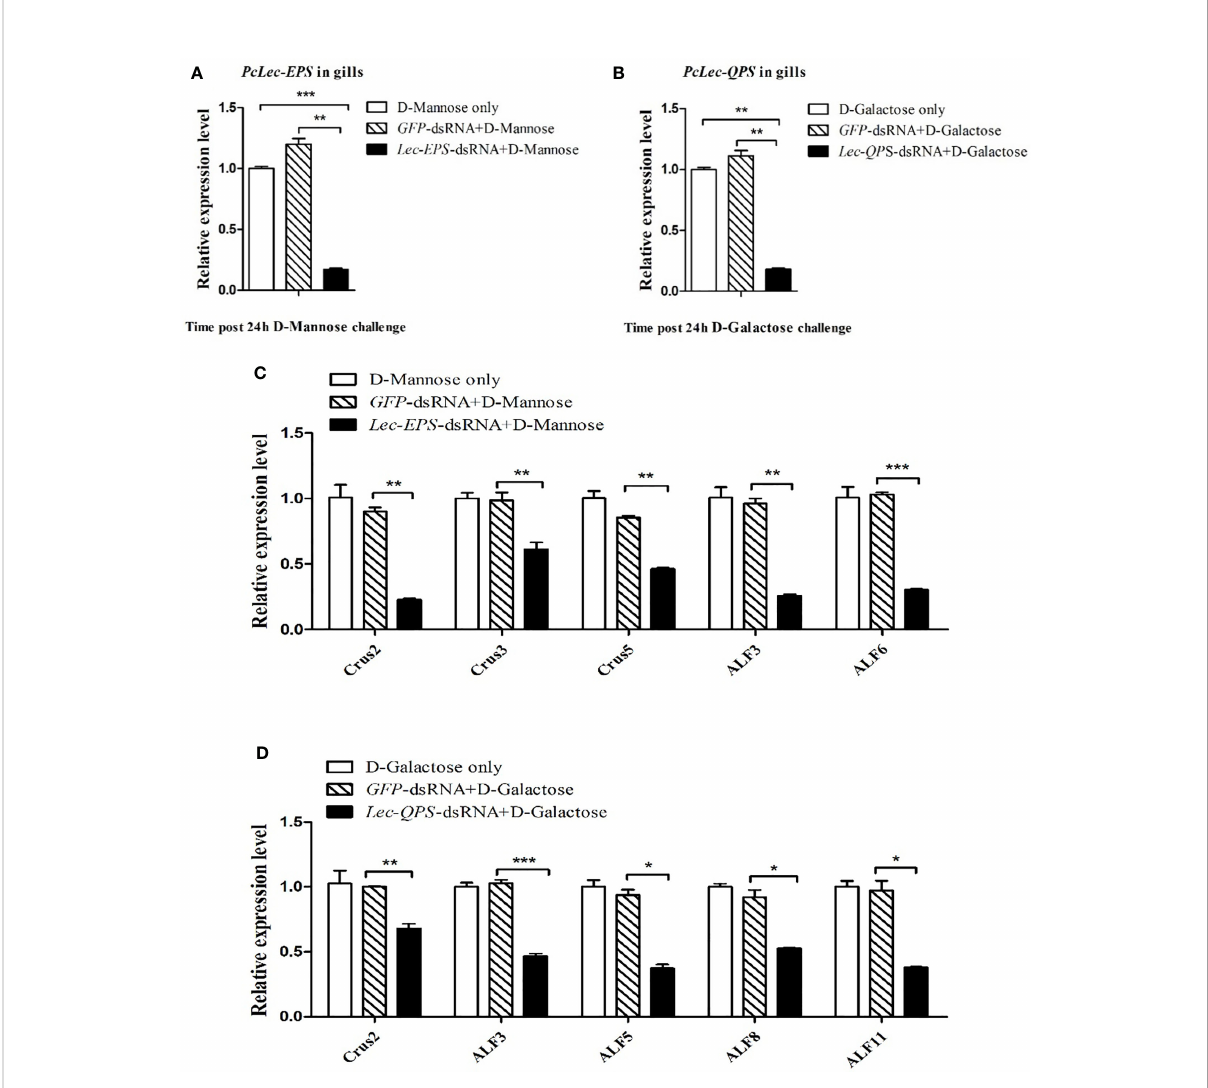
FIGURE 7 Analysis of AMPs expression regulation after carbohydrate (D-Mannose or D-Galactose) challenge in CTL ( PcLec-EPS or PcLec-QPS ) knockdown cray fi shes. (A) Detection of the expression of PcLec-EPS at 24 h of D-Mannose challenge in the gills of PcLec-EPS knockdown cray fi shes. (B) Detection of the mRNA expression of PcLec-QPS at 24 h of D-Galactose challenge in the gills of PcLec-QPS knockdown cray fi shes. (C) Detection of the expression levels of AMPs ( Crus2 , Crus3 , Crus5 , ALF3 , and ALF6 ) at 24 h of D-Mannose challenge in the gills of PcLec-EPS knockdown cray fi shes. (D) Detection of the transcriptional levels of AMPs ( Crus2 , ALF3 , ALF5 , ALF8 , and ALF11 ) at 24 h of D- Galactose challenge in the gills of PcLec-QPS knockdown cray fi shes. D-Mannose only, D-Galactose only, GFP- dsRNA plus D-Mannose, and GFP- dsRNA plus D-Galactose were used as control groups. Data are presented as mean ± SD, N=5. The asterisk indicated signi fi cant difference between experimental group and control group (* p < 0.05, ** p < 0.01, and *** p <